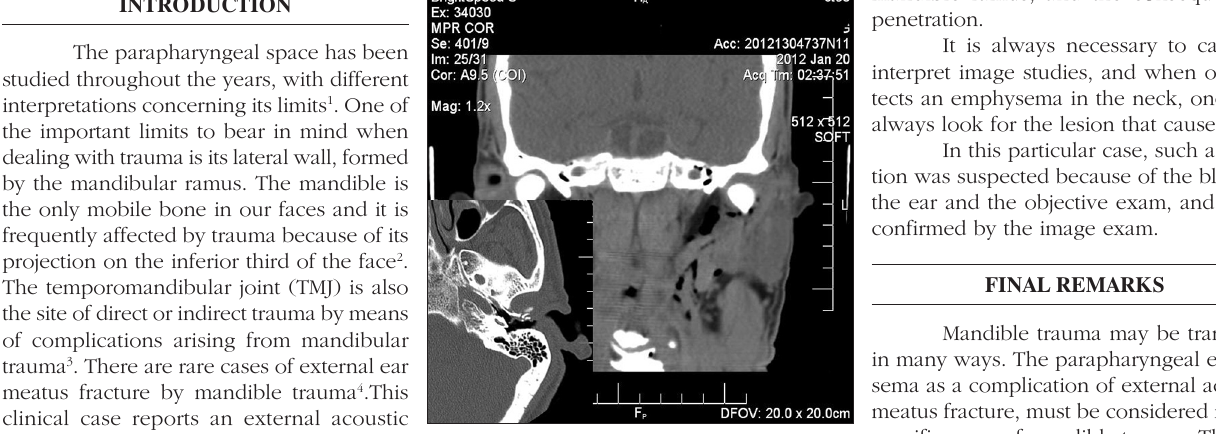
Figure 1. Coronal and axial CT images. External auditory canal anterior wall fracture and consequent emphysema of the ipsilateral parapharyngeal